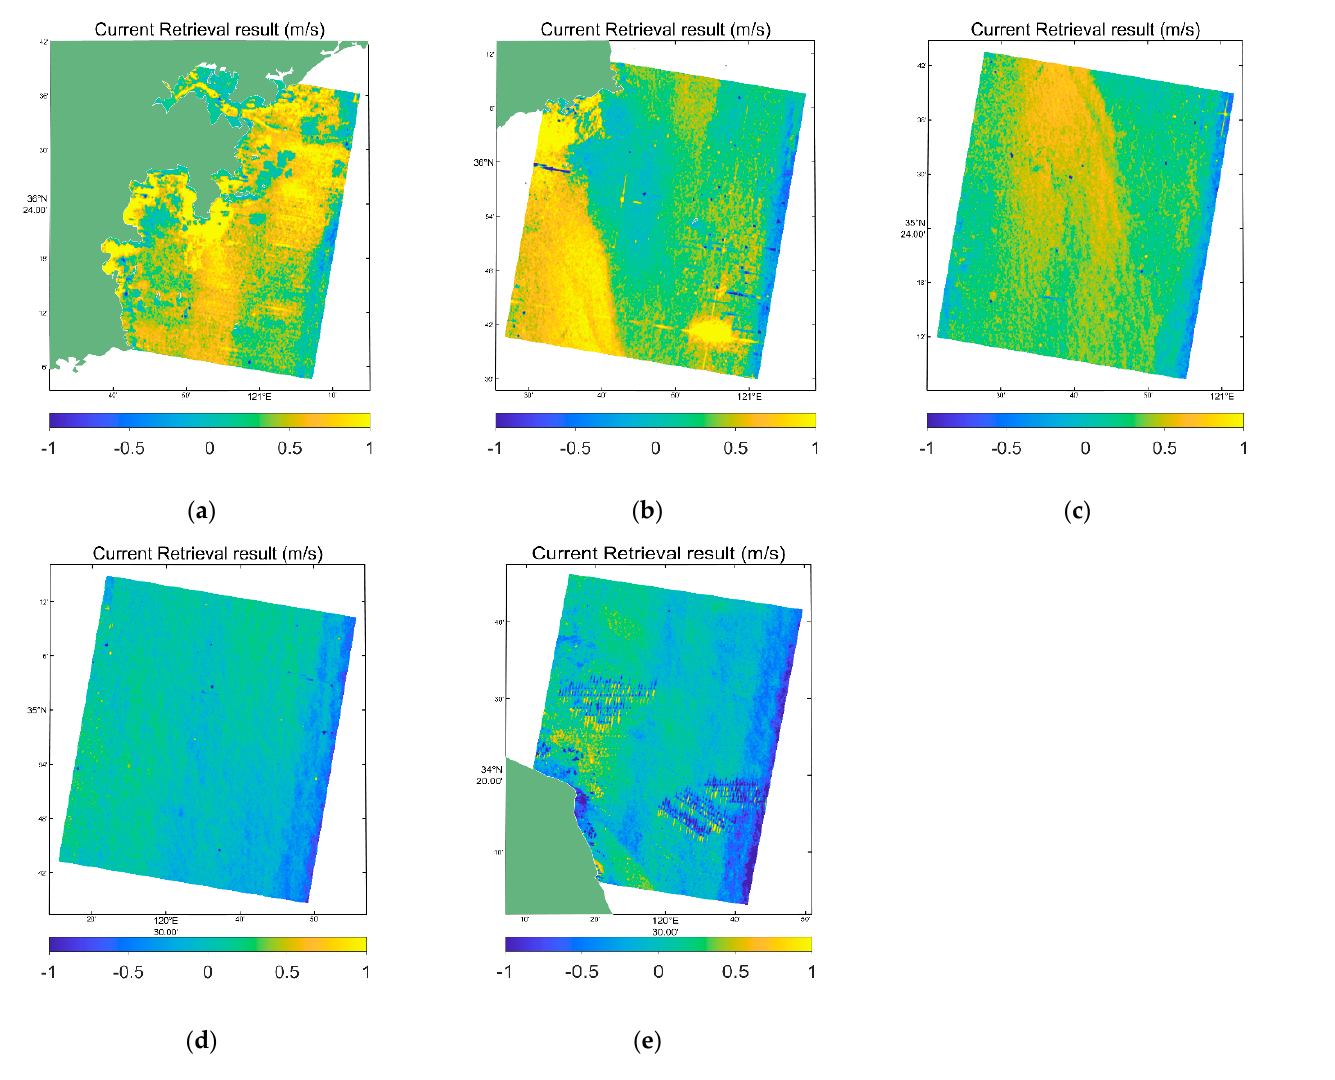
( e ) Figure 10. Results of retrieving the Doppler anomaly DA f